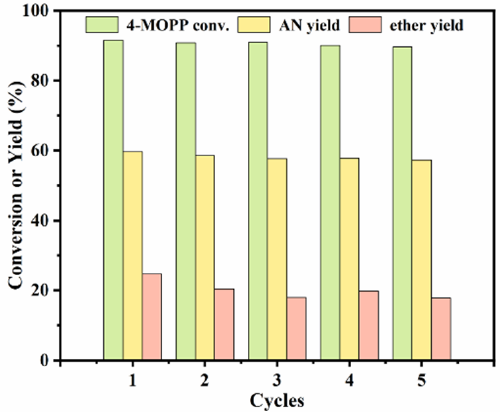
Figure 9. Reusability of the PhP-Hf (1:1.5) catalyst; Reaction conditions: 1 mmol 4-MOPP, 10 mL 2-pentanol, 0.1 g PhP-Hf (1:1.5) catalyst, 220 °C for 2 h.